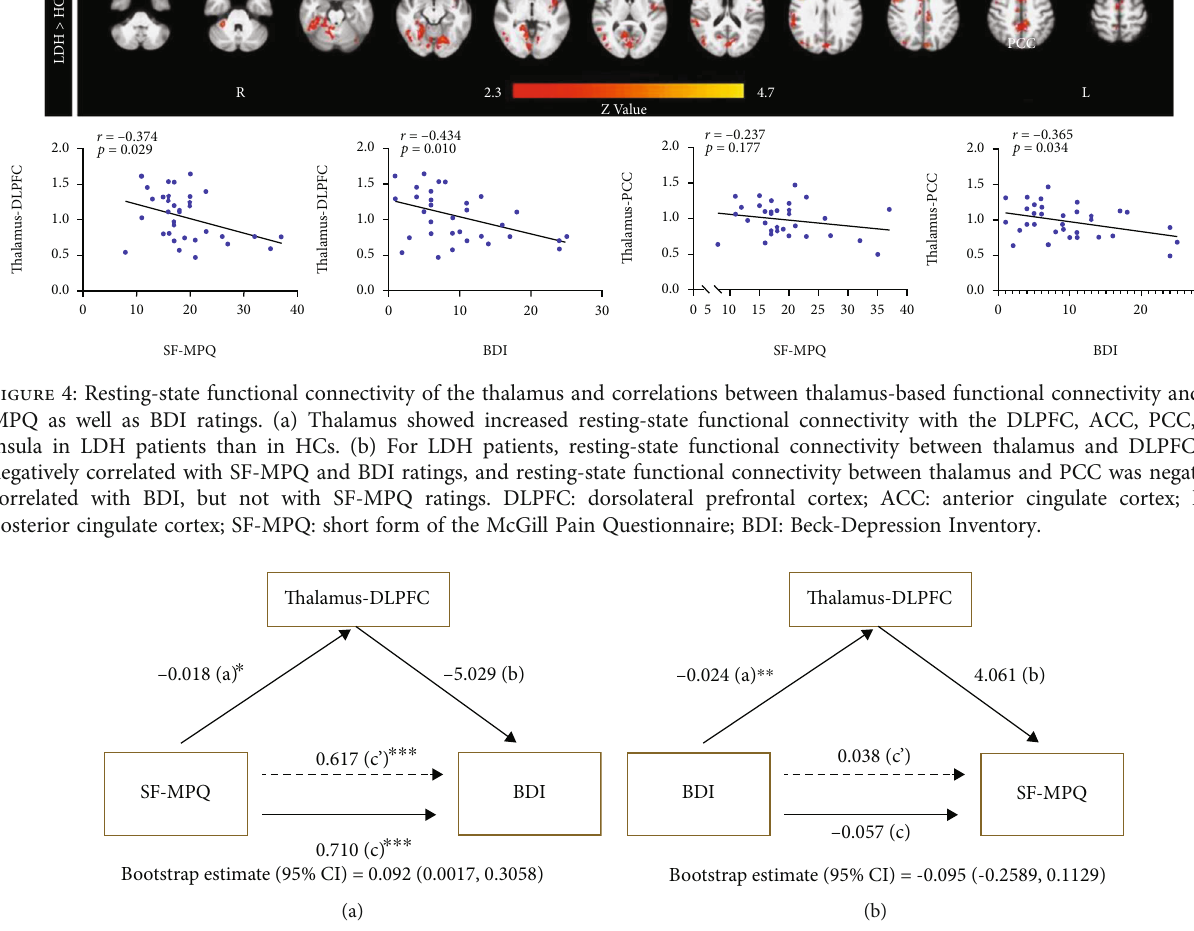
Figure 5: Mediation analysis. (a) The thalamus-DLPFC temporal coupling mediated the relationship from SF-MPQ to BDI. Path c is the total e ff ect of SF-MPQ on BDI; path c ’ is the direct e ff ect of SF-MPQ on BDI after controlling for the thalamus-DLPFC functional connectivity; the product of a and b (ab) is the indirect e ff ect of SF-MPQ through the thalamus-DLPFC functional connectivity on BDI. (b) In contrast, the thalamus-DLPFC temporal coupling did not mediate the relationship from BDI to SF-MPQ. Path c is the total e ff ect of BDI on SF-MPQ; path c ’ is the direct e ff ect of BDI on SF-MPQ after controlling for the thalamus-DLPFC functional connectivity; the product of a and b (ab) is the indirect e ff ect of BDI through the thalamus-DLPFC functional connectivity on SF-MPQ. SF-MPQ: short form of the McGill Pain Questionnaire; BDI: Beck-Depression Inventory. DLPFC: dorsolateral prefrontal cortex. ∗ p < 0 : 05 , ∗∗ p < 0 : 01 , and ∗∗∗ p < 0 : 001